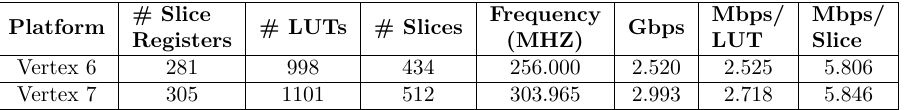
Table 4: Beetle[Secure+] Implemented FPGA